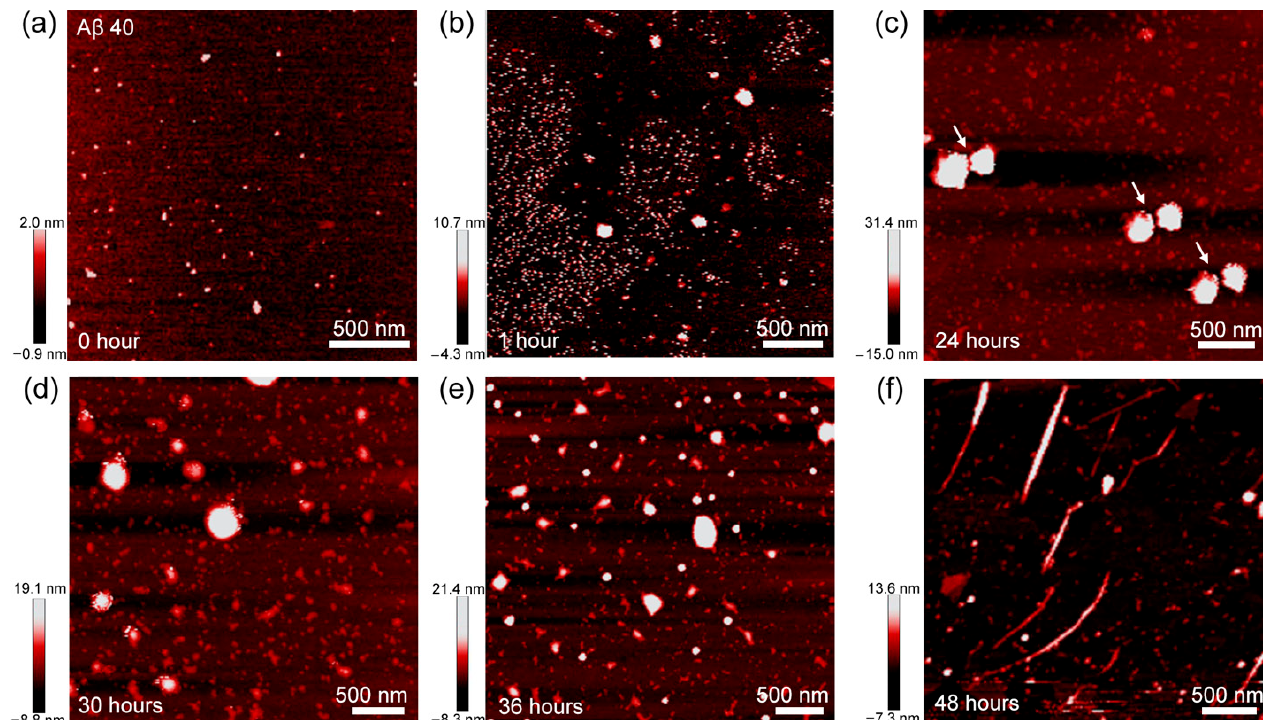
Figure 3. AFM images of A β 40 aggregates that are made under the incubation time of (a) 0 h, (b) 1 h, (c) 24 h, (d) 30 h, (e) 36 h, and (f) 48 h, respectively. The white arrows indicate two large particles with similar radius are fusing together.